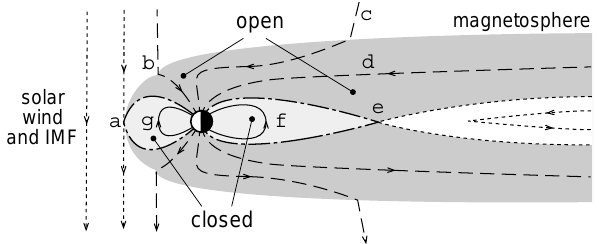
Fig. 1. A schematic diagram of the magnetosphere in the noon- midnight meridian. The solar wind and IMF impinge from the left, IMF field lines represented by dotted curves. Full and dashed curves show closed and open field lines, respectively. The dot-dashed lines indicate the open/closed field line boundary, the ionospheric projec- tion of which is the polar cap boundary. Letters a to g indicate the evolution of field lines during the Dungey